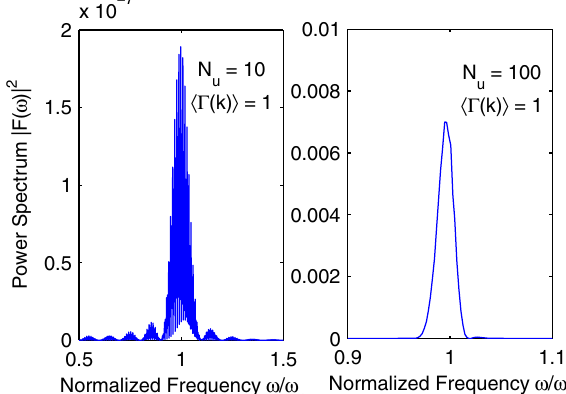
FIG. 8. Typical spectrums of the dimensionless power j F ð ! Þj 2 vs the frequency normalized to the resonant frequency !